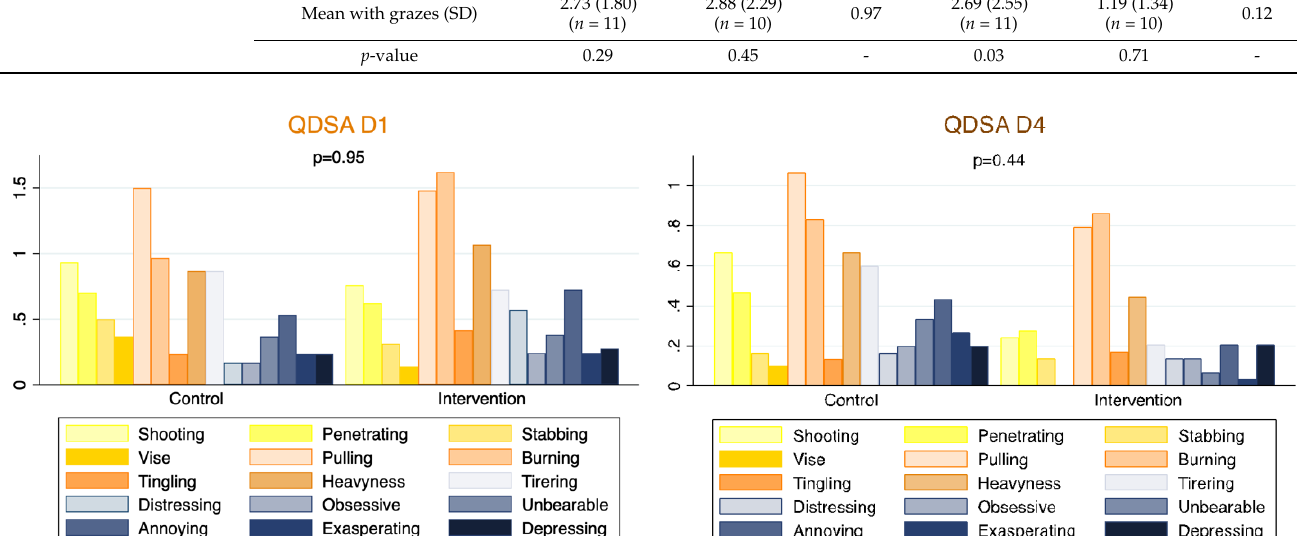
Table 2. Representation of the effectiveness of honey before randomization.